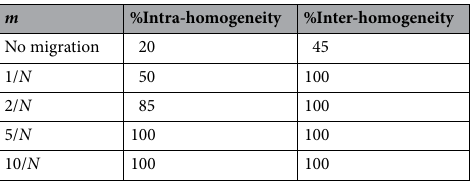
Table 2. Number of coincidences in collective agreements between different groups for different values of migrating fraction of population ( m